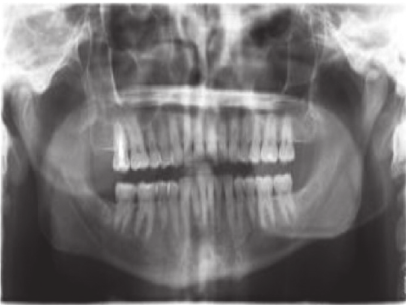
Figure 4: Panoramic